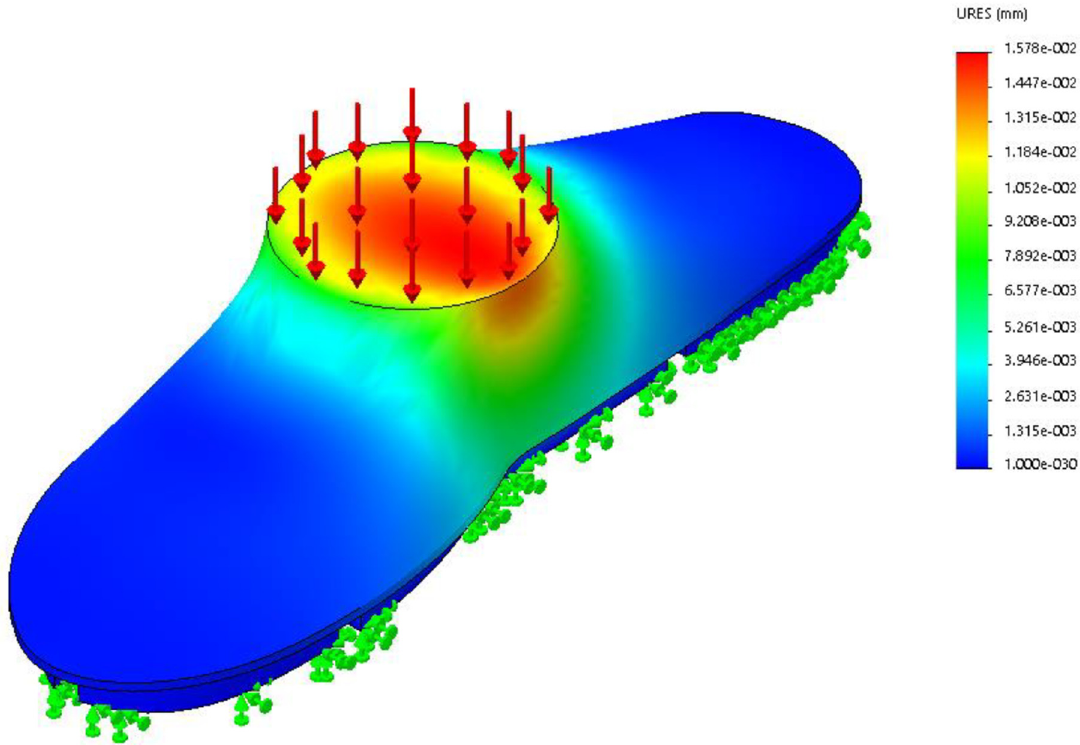
Figure 9. SolidWorks Loading with 100 kg Load.